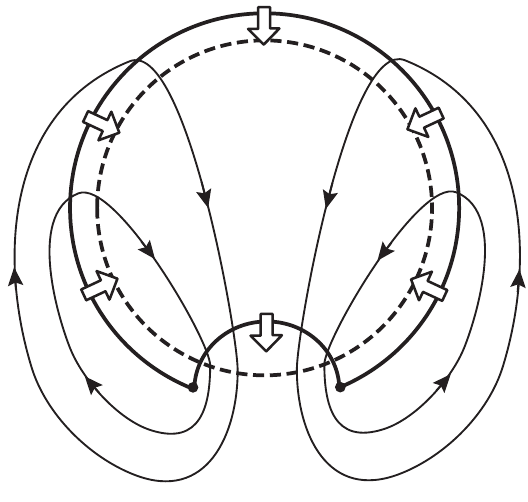
Fig. 9. Schematic of the flow which is excited by a single short- Fig. 9 lived pulse of nightside reconnection. The instantaneous open- closed field line boundary is shown by the heavy solid line, while the plasma streamlines are shown by the lighter arrowed lines. The implied boundary motion is illustrated by the large arrows, and the equilibrium boundary position is indicated by the dashed circle.